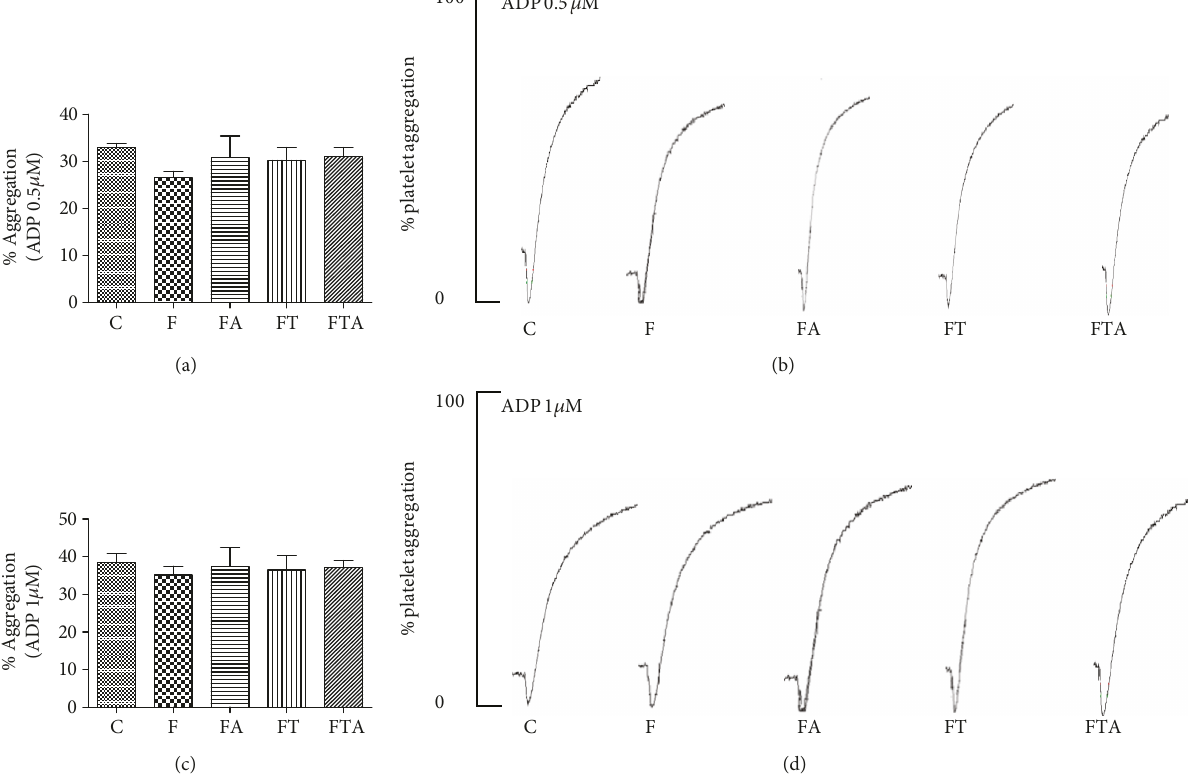
Figure 3: Platelet aggregation induced by ADP 0.5 μ M (a, b) and ADP 1 μ M (c, d) after 8 weeks of fructose overload. C group: control group; F group: fructose group; FA group: fructose +arginine group; FT group: fructose +training group; FTA group: fructose +training +arginine group. Data are presented as means ± SEM . Statistical analysis (one-way ANOVA and post hoc Bonferroni multiple comparison test): ∗ P < 0 05 v. the C group and # P < 0 05 v. the F group.